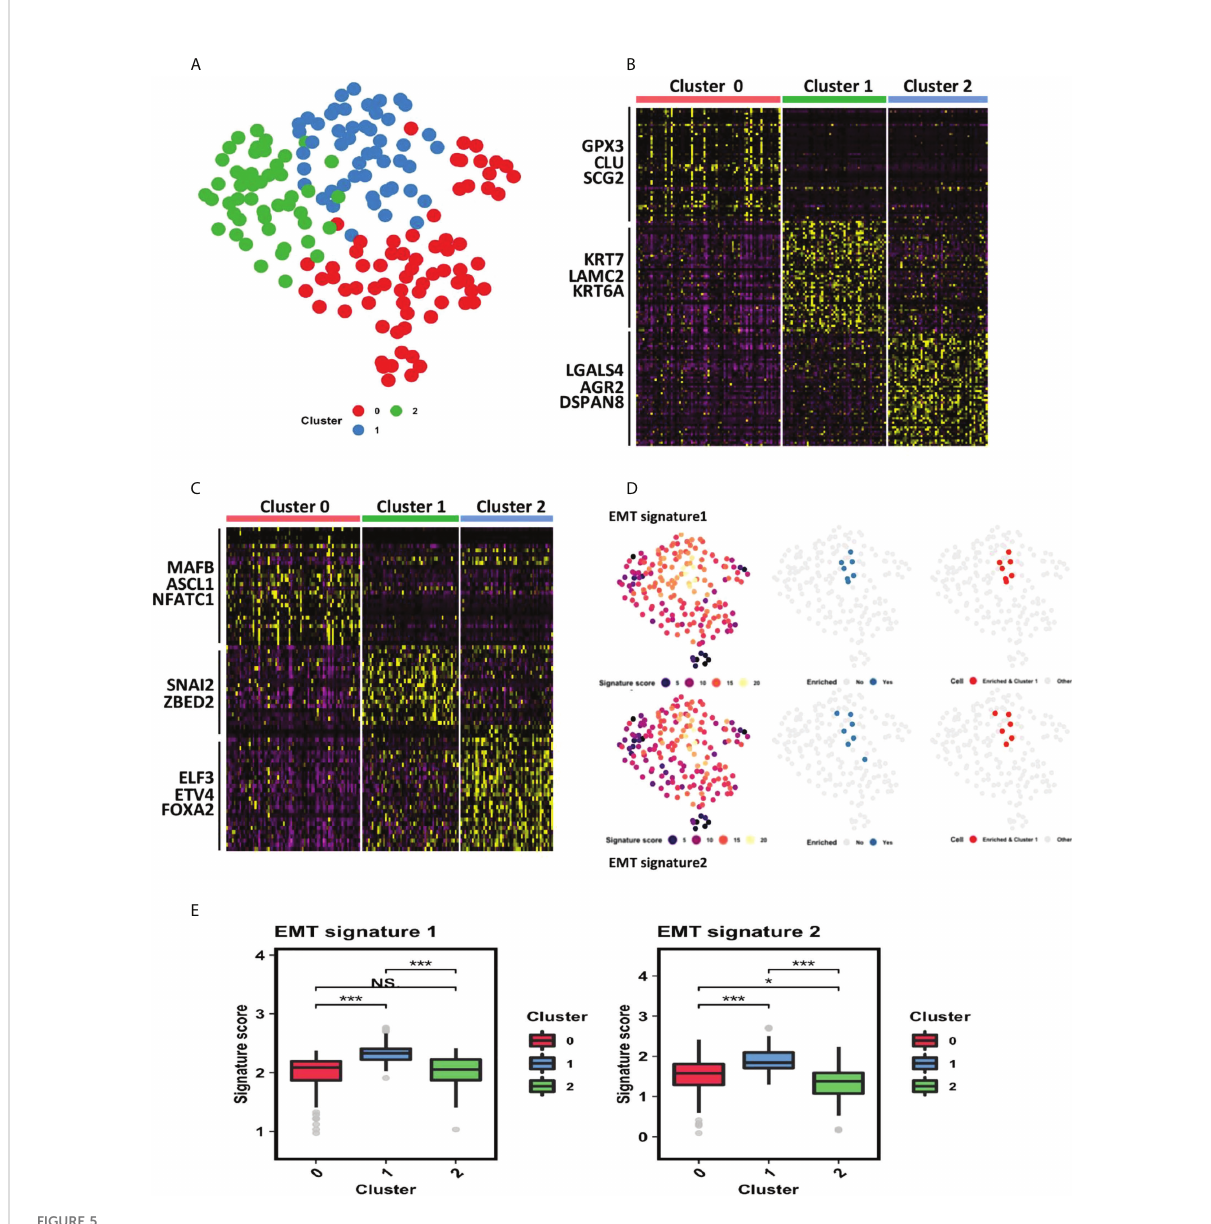
FIGURE 5 Cluster 1 identi fi ed by the clustering analysis of PDAC TCGA dataset is associated with epithelial – mesenchymal transition (EMT). (A) Clustering analysis of PDAC TCGA dataset identi fi ed 3 distinct clusters (cluster 0, cluster 1 and cluster 2) projected onto UMAP coordinates. (B) Heatmap showing top 50 differentially expressed genes for each cluster. Red represents cluster 0, green represents cluster 1, and blue represents cluster 2. (C) Heatmap showing top 30 differentially expressed transcription factors for each cluster. Red represents cluster 0, green represents cluster 1, and blue represents cluster 2. (D) Gene set enrichment analysis in all three clusters of PDAC patients. The tested gene sets were gene signatures extracted from previous literature that are strongly related to EMT. The fi rst column showcases the signature score each patient earns. The higher the signature score, the more enriched the corresponding patient is for each gene set. The second column showcases all patients with a high signature score (ranked at 95th percentile or above). The third column showcases that patients highly enriched for each gene set all belong to cluster 1. (E) Statistical comparison of EMT signature scores of patients in the three clusters. *P< 0.05; ***P< 0.001; Ns, not signi fi